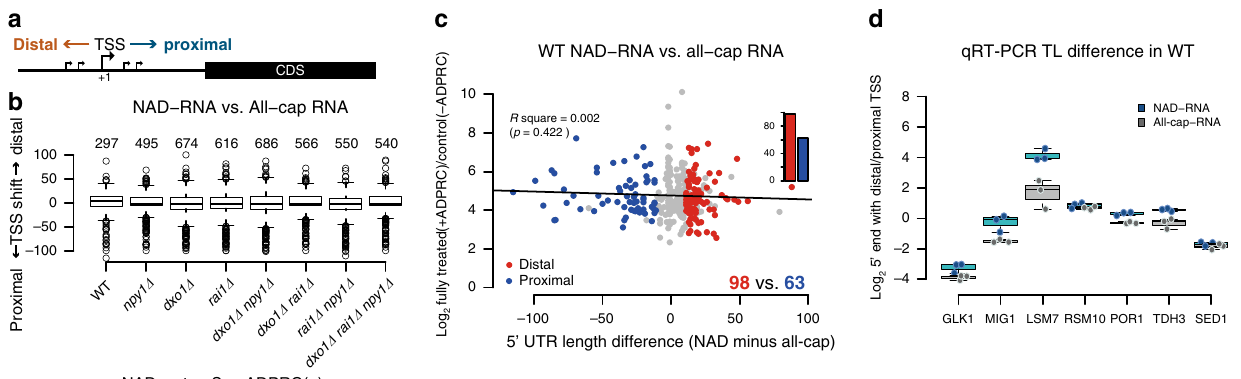
Fig. 6 NAD-RNAs have longer 5 ′ -UTRs than non-NAD-RNAs. a Scheme of TSS shifting in proximal or distal direction. b Global TSS shifting between NAD-RNA (according to NAD captureSeq, unfragmented libraries) in all strains and canonical RNA (according to the dataset of Nagalakshmi et al. 18 ). The boxplot shows from bottom to top minimum (Q1 – 1.5 interquartile range (IQR, 25 – 75%)), fi rst quartile (Q1, 25%), median (solid line, 50%), third quartile (Q3, 75%), maximum (Q3 + 1.5 IQR), and outliers (black dots). The numbers above each box group indicates the number of RNA species analyzed in the corresponding strain. c Detailed TSS shifting between NAD-RNA and All-cap RNA in WT strain, 5 ′ -UTR length difference denotes NAD-RNA 5 ′ -UTR length minus canonical (all-cap) RNA 5 ′ -UTR length. Red dots represent NAD-RNA species with distal TSS ( > 10 nt difference) and blue dots represent NAD-RNA species with proximal TSS ( > 10 nt difference). FDR wilcox < 0.1. The sample size ( n ) is 347. The black line represents the linear correlation between 5 ′ -UTR length and NAD-RNA enrichment level. d qRT-PCR with different primer pairs con fi rming different transcript leader (TL) lengths between NAD-capped RNAs (enriched fraction from NAD captureSeq library, blue boxes) and all-capped RNAs (from non-enriched input RNA, gray boxes). The boxplot displays the log 2 of the ratio of the number of transcripts derived from the distal TSS to that from the proximal TSS. The layout of boxplot is as de fi ned in b . Dots represent individual biological triplicate measurements. Source data are provided as a Source Data fi